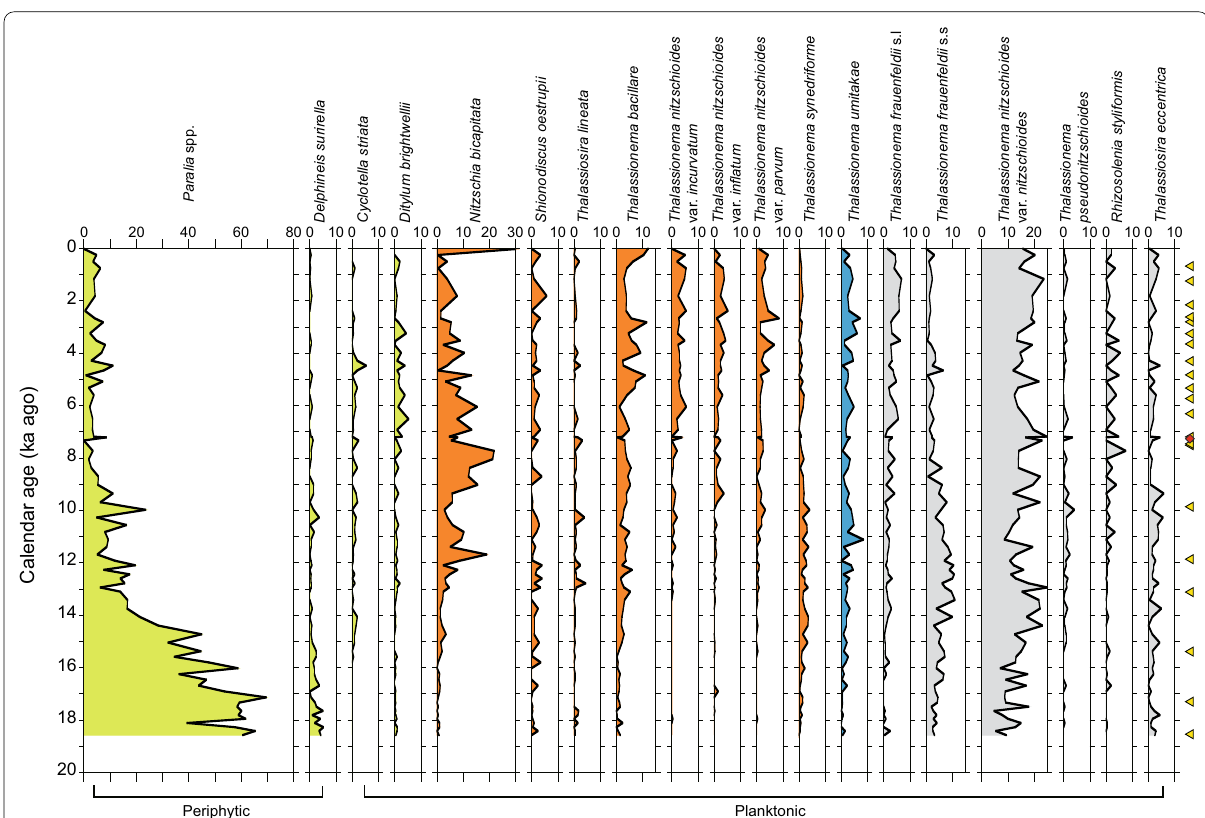
Fig. 3 Downcore profiles of relative abundances (%) of major diatom taxa with greater than 4% at least in a sample of Core KY07-04 PC01 grouped by the geographic distributions: coastal (light green); warm (orange); blue (cold); and non-specific geographic distribution (grey) (Table 2). Yellow triangles and a red diamond on the right denote radiocarbon dates and K-Ah tephra,